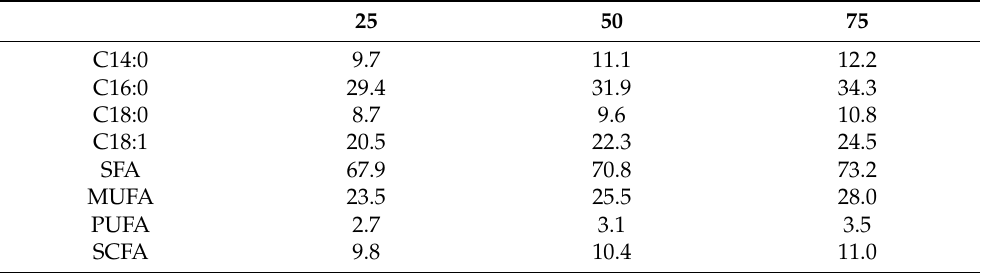
Table 2. Myristic (C14:0), palmitic (C16:0), stearic (C18:0), oleic (C18:1), saturated (SFA), monoun- saturated (MUFA), polyunsaturated (PUFA) and short chain fatty acid (SCFA) (g/100 g fatty acids) quartile distributions in milk samples from dairy cows in Galicia (NW